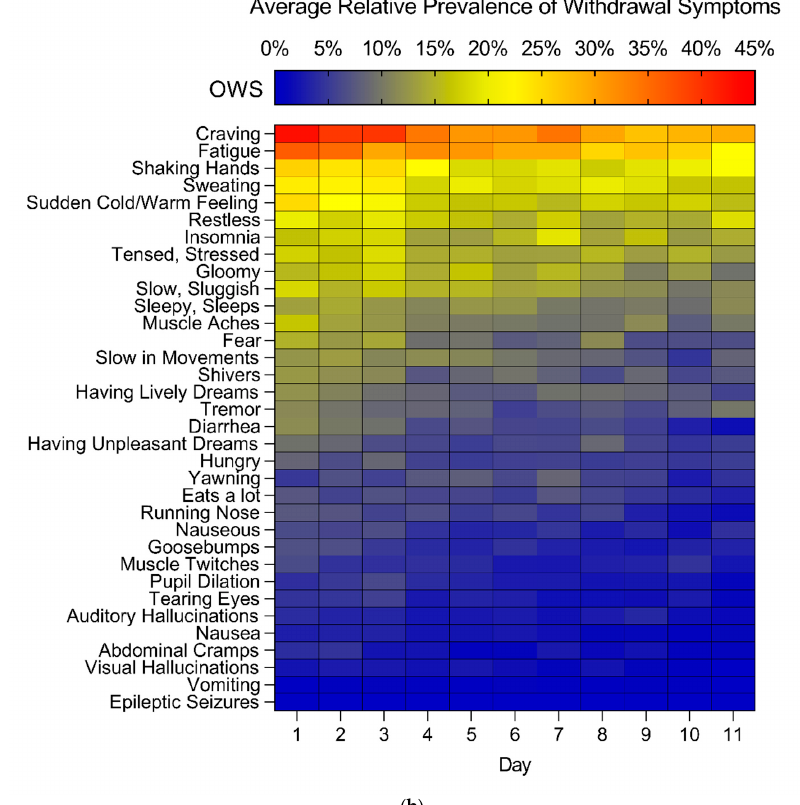
Figure 2. Average relative severity and prevalence of subjective- and objective withdrawal symptoms. ( a ) Heat map of all 33 SWS over time for the first 11 detoxification days. Symptoms are ranked based on the average severity of the symptom over all days for males and females combined. ( b ) Heat map of all 34 OWS over time for the first 11 detoxification days. Symptoms are ranked based on the average presence of the symptom over all days for males and females combined.